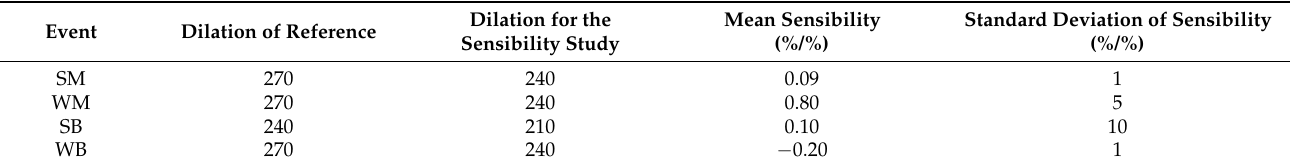
Table 5. Dilation sensitivity study for the four case